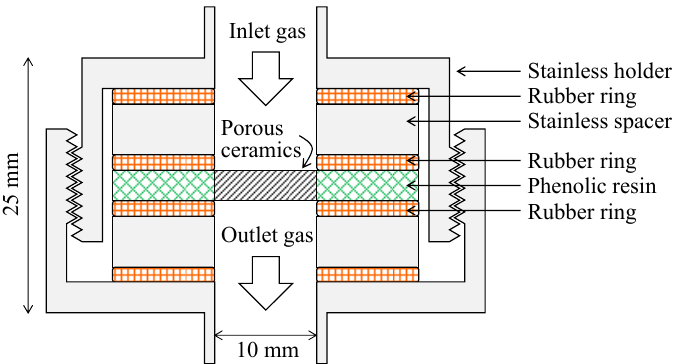
Figure 3. Gas permeation apparatus with porous ceramics.